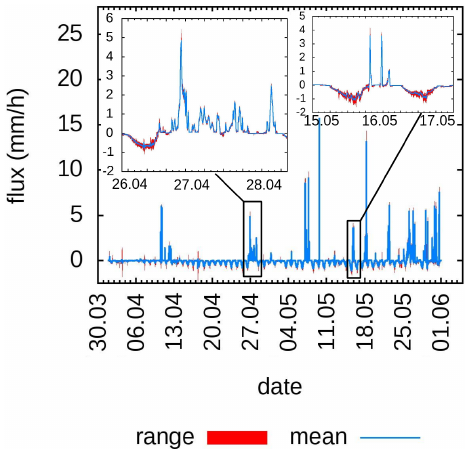
Figure 6. Variations in the calculated fluxes between the different crop lysimeters. The area in red shows the range of minimal and maximal calculations.